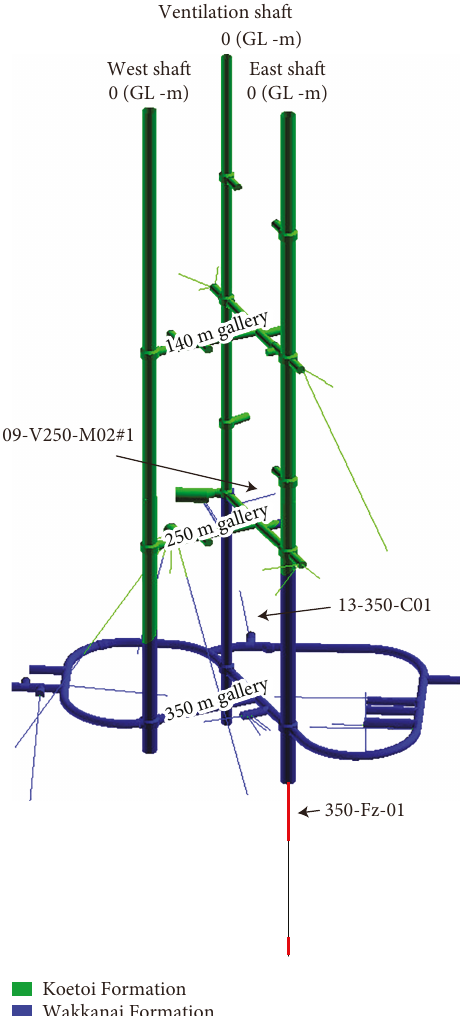
Figure 3: Layout of the Horonobe URL, locations of boreholes, and surrounding geology. Red color-labelled “ borehole 350-Fz-01 ” indicates core sampling depths (Table